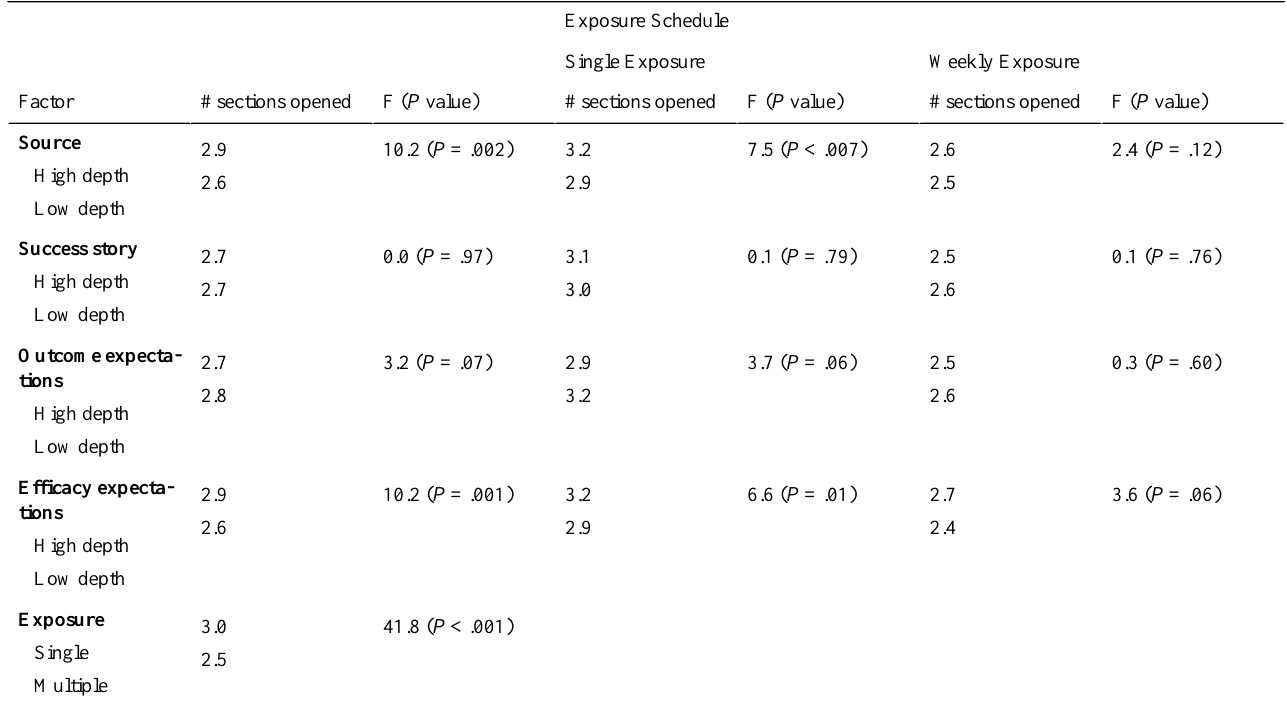
Table 3. Program engagement a of each intervention component by intervention components (n=1866)